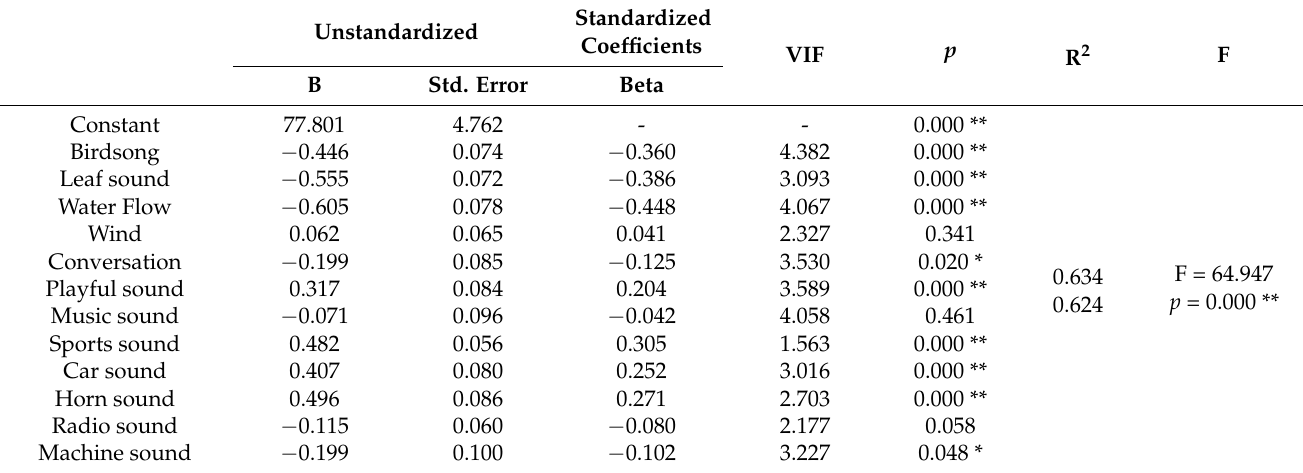
Table 10. Linear regression model of acoustic environment type and